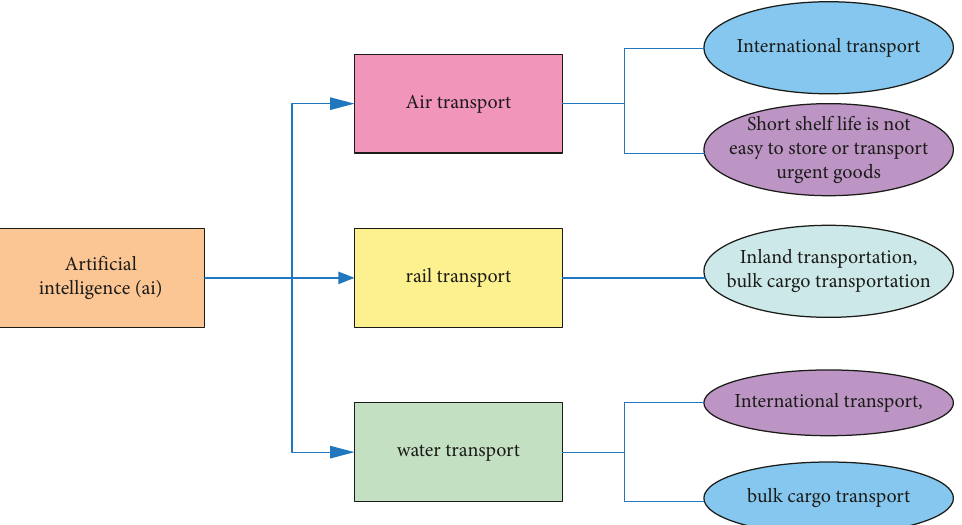
Figure 1: The use of artificial intelligence in transportation.